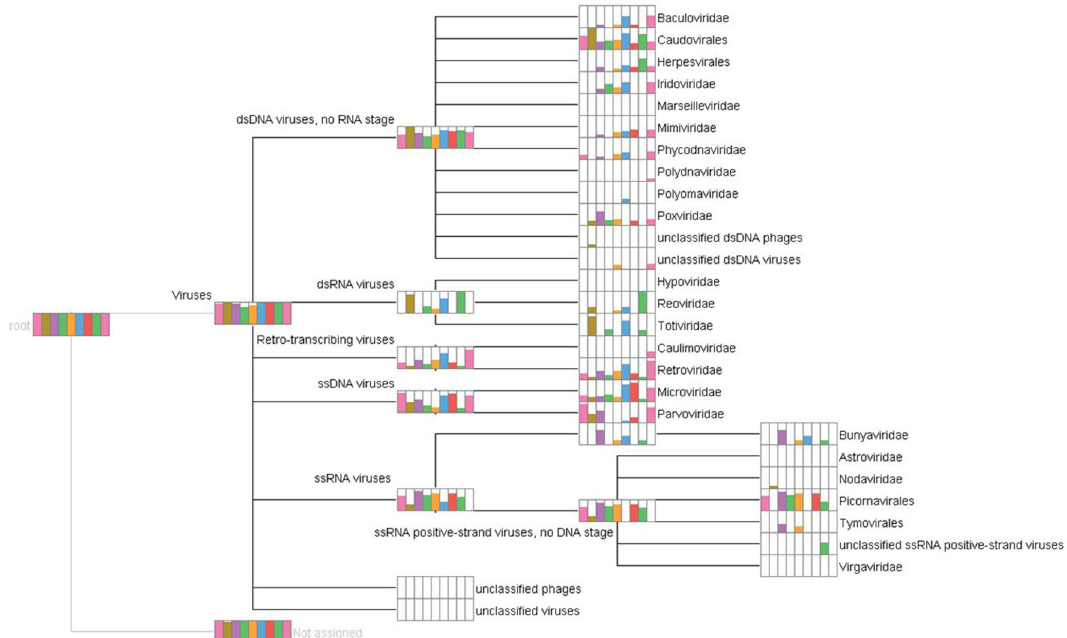
Figure 1. Comparison of all pools with MEGAN6. The different colors stand for the individual pools: pool 1 pink, pool 2 light brown, pool 3 brown, pool 4 light green, pool 5 yellow, pool 6 blue, pool 7 red, pool 8 green, pool 9 light pink. The height of the color bars indicates the percentage of viruses found in the corresponding nodes of the taxonomic